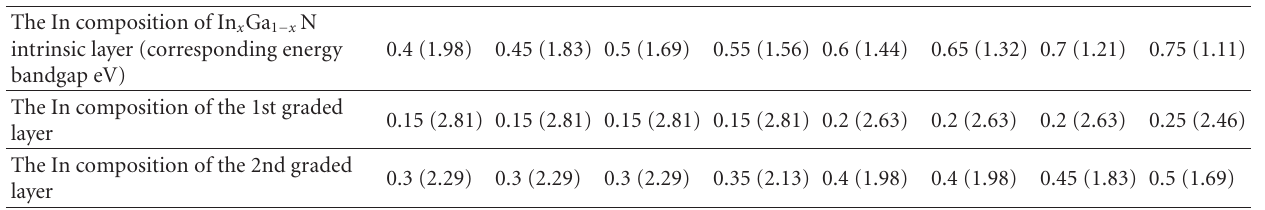
Table 2: The optimum In-composited combination of two graded layers for each In composition of In x Ga 1 − x N pin solar cells. The In composition of In x Ga 1 − x N intrinsic layer (corresponding energy